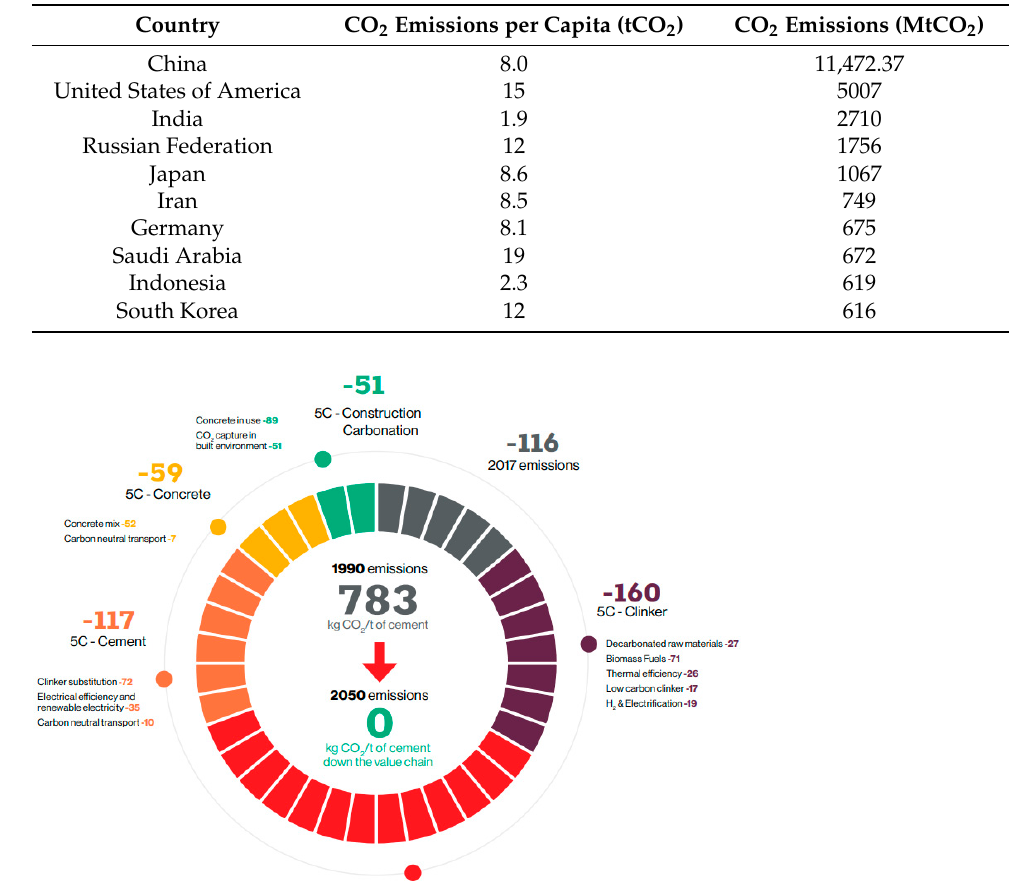
Table 1. Carbon emissions per capita in major countries [10].